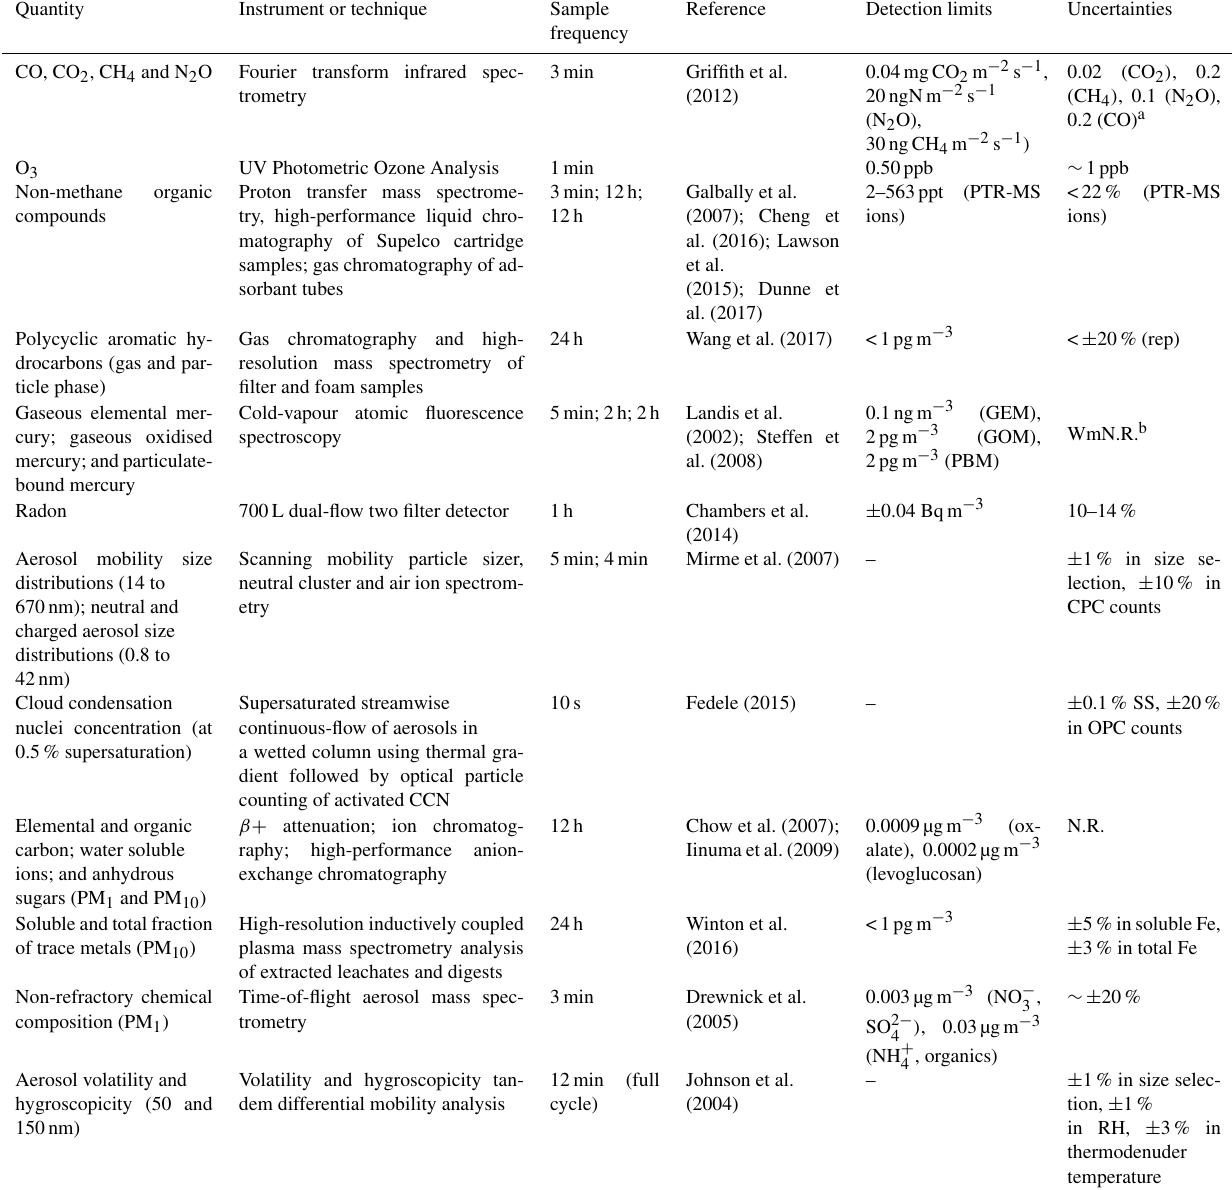
Table 1. A summary of the quantities measured during SAFIRED and the respective instrument or measurement technique. Detection limits and uncertainties are expressed for select instruments or